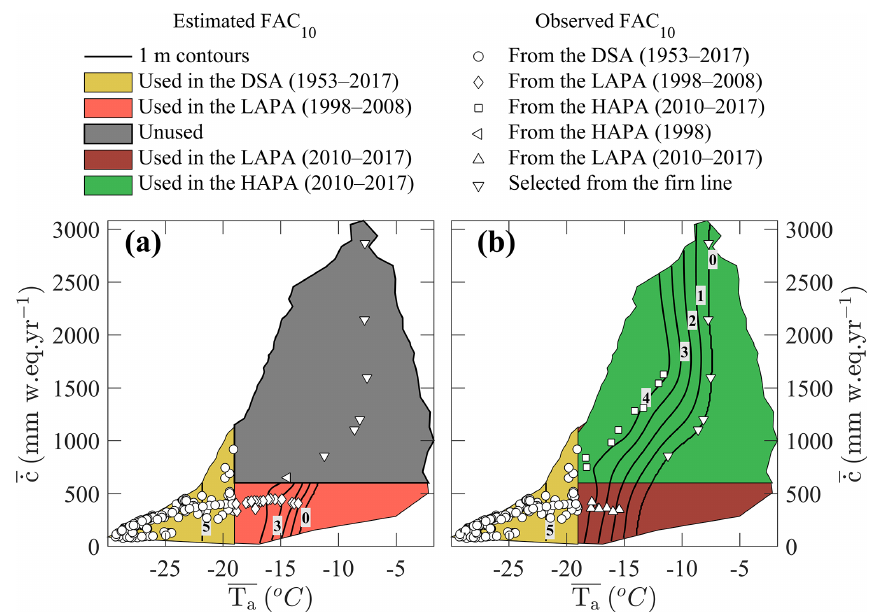
Figure 3. Contours (labelled black lines) of the empirical functions of T a and ˙ c used to estimate FAC 10 along with the FAC 10 observations used to constrain the functions. Two functions could be constructed: (a) describing FAC 10 in the LAPA during 1998–2008 and (b) describing FAC 10 in the LAPA and HAPA during 2010–2017.